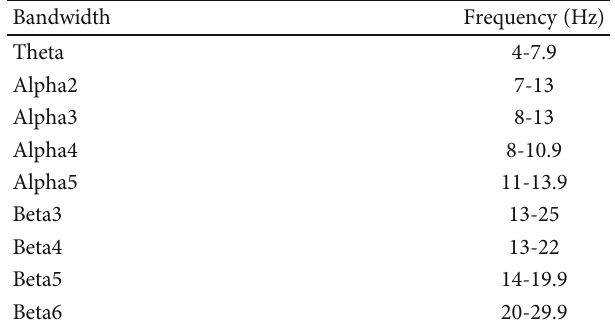
Figure 11: Sensor location on a Table 1: Representation of frequency bands (alpha, beta, and theta).